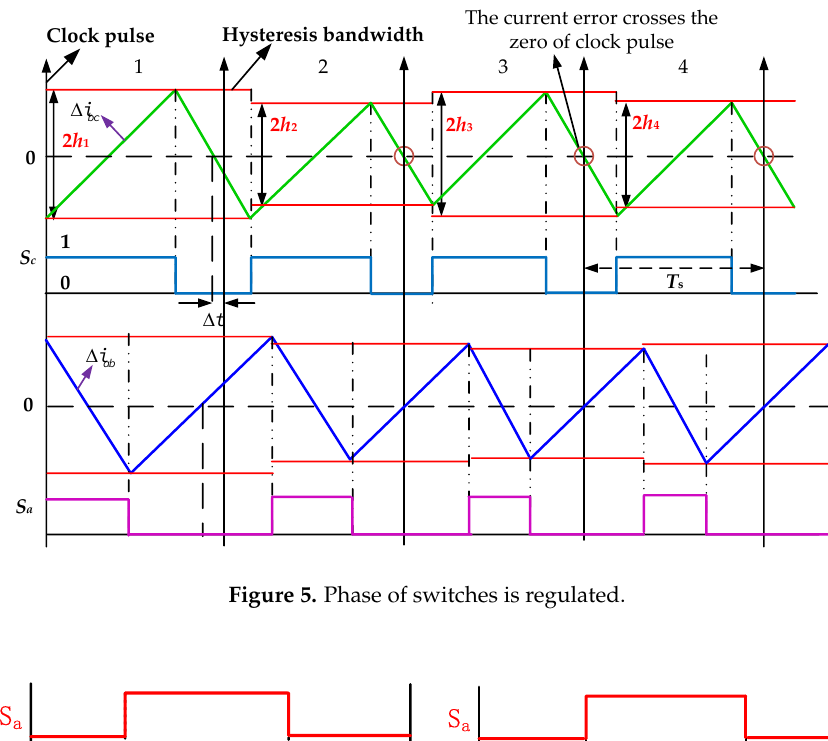
Figure 5. Phase of switches is regulated.